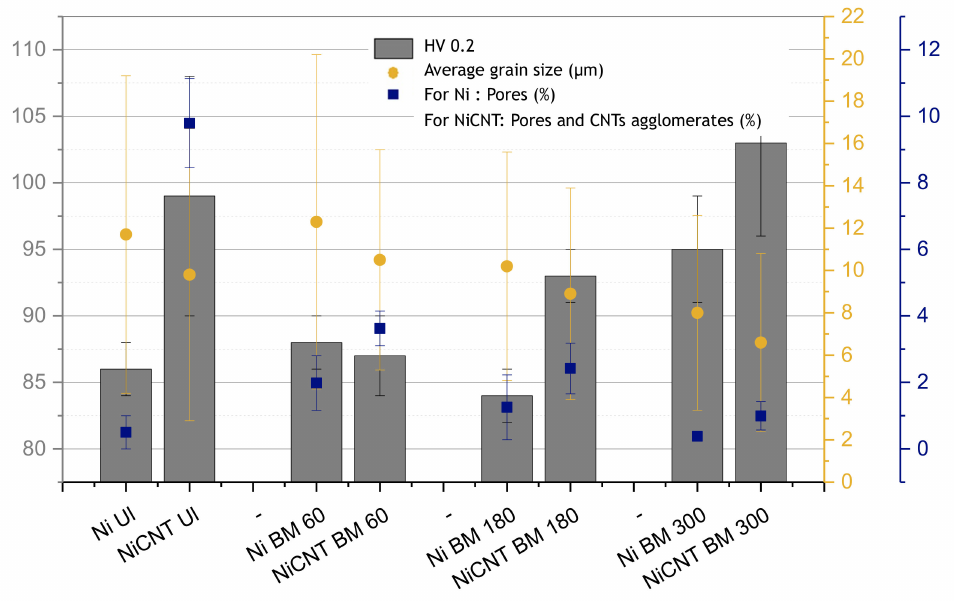
Figure 2. Hardness values (HV 0.2), average grain size, and number of pores and CNTs agglomerates for the samples produced with different dispersion/mixture processes: ultrasonication (Ul) and ball milling (BM) for 60, 180, and 300